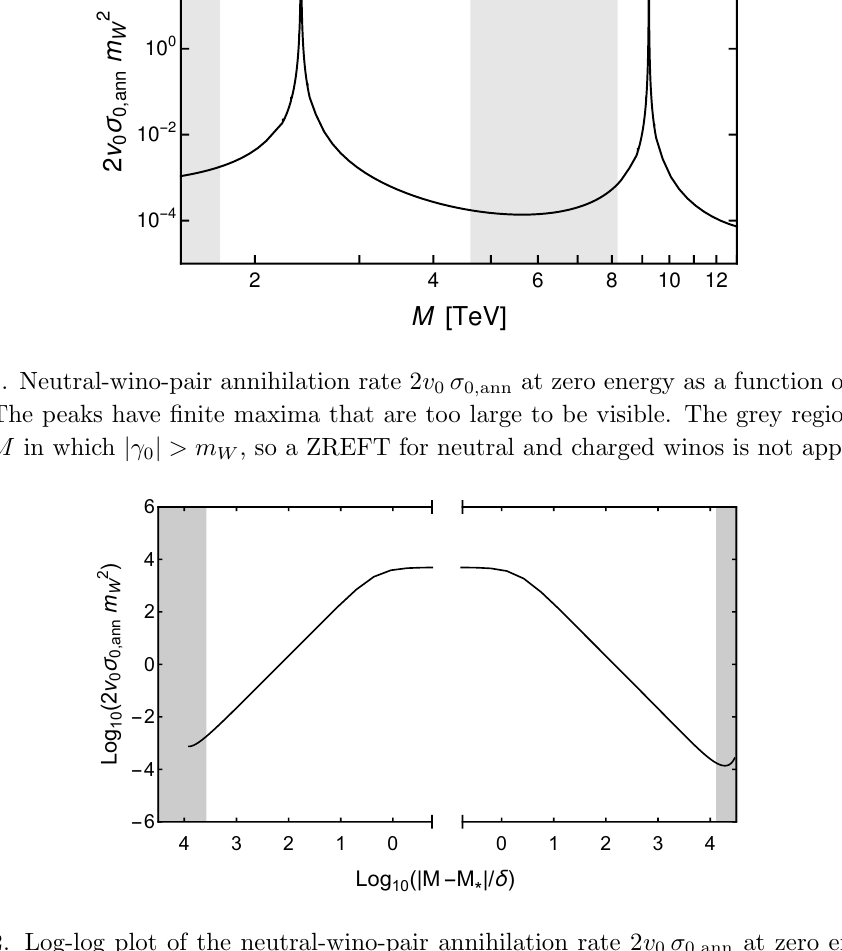
Figure 12 . Log-log plot of the neutral-wino-pair annihilation rate 2 v 0 (cid:27) 0 ; ann at zero energy as a function of the wino mass M . The horizontal axis is the logarithm of j M (cid:0) M (cid:3) j =(cid:14) , with M increasing towards M (cid:3) on the left side of the plot and with M increasing away from M (cid:3) on the right side of the plot. The grey regions are the ranges of M in which j (cid:13) 0 j > m W , so a ZREFT for neutral and charged winos is not